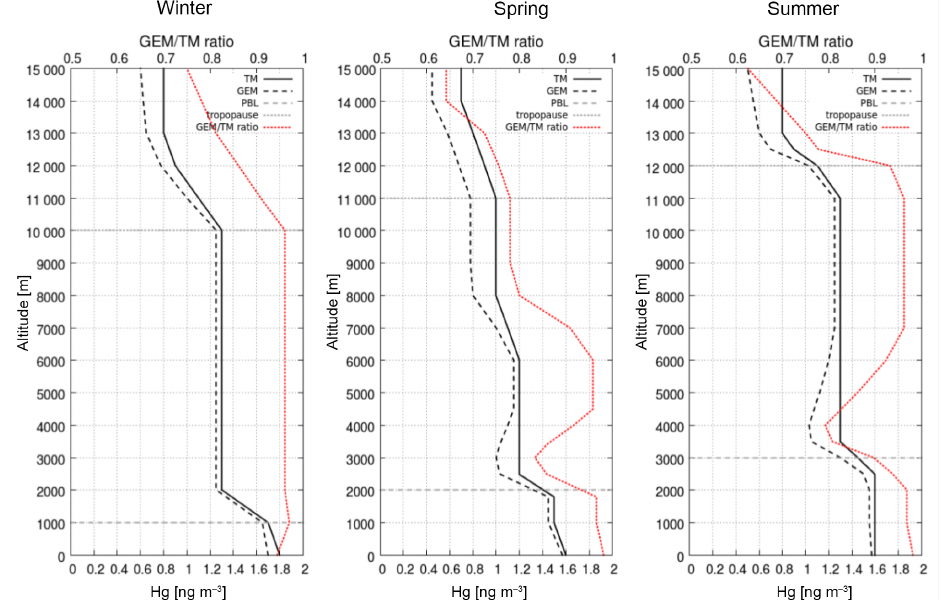
Figure 1. Idealized observed TM and GEM mercury profiles for winter, spring, and summer in northern midlatitudes. The depicted profiles are based on aircraft observations from CARIBIC, ETMEP, NOMADSS, and Tullahoma flights. Data gaps in altitude where no observations are available were